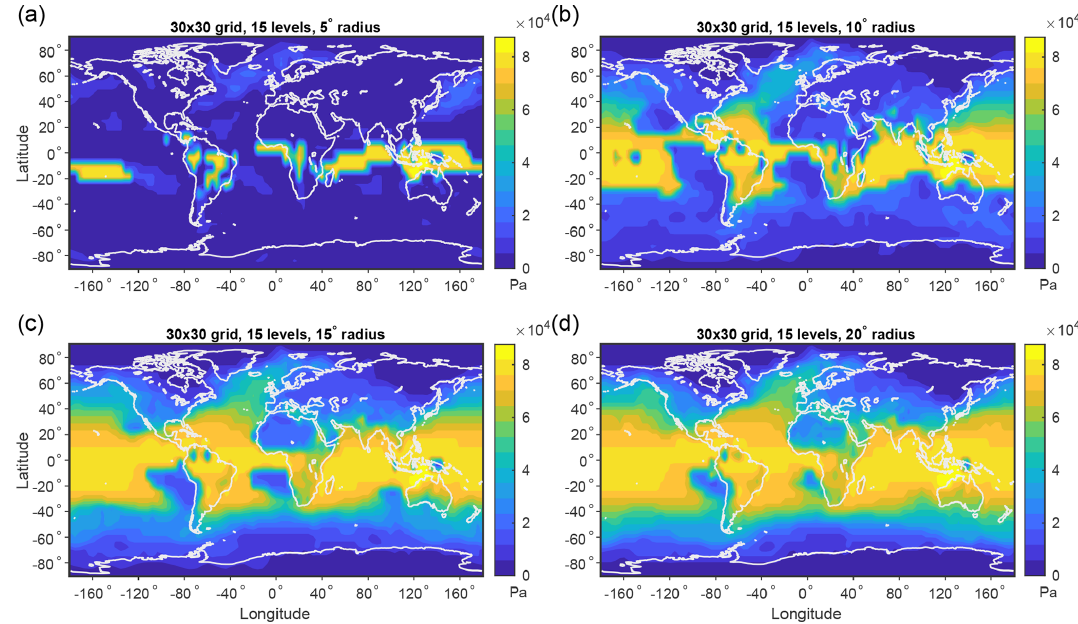
Figure B4. Maximum potential ascent in local MAPE based on the DJF climatological mean over 1979-2018 using subdomains of varying geodesic radii: (a) 5 ◦ (560km), (b) 10 ◦ (1110km), (c) 15 ◦ (1670km), and (d) 20 ◦ (2230km). All results in this figure use 1800 surface grid cells (a 30 × 30 grid in each hemisphere) and 15 pressure